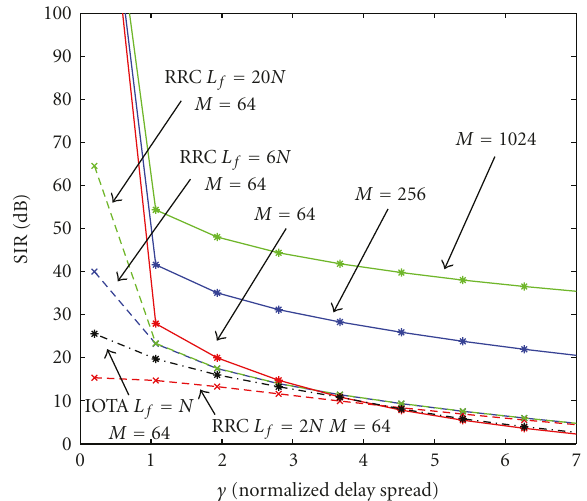
Figure 16: Capacity of the FMT with M = 64, N = 80, and L f = 80 versus OFDM with M = 64, and CP = 16